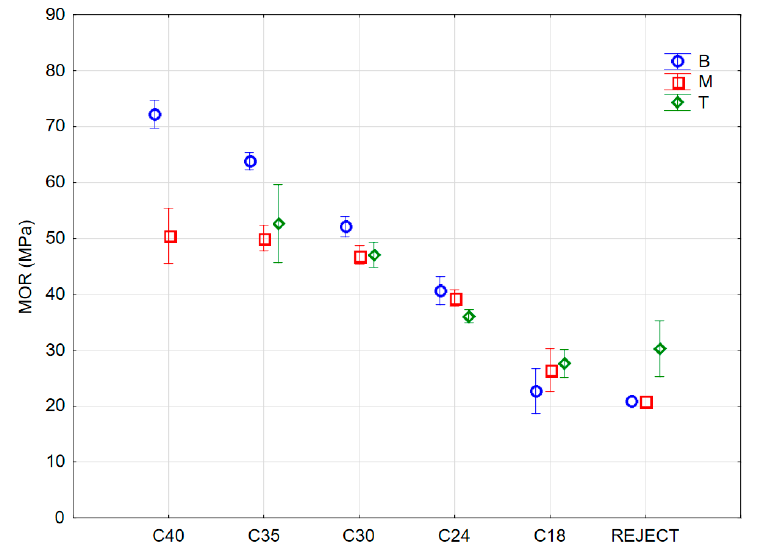
Figure 5. MOR distribution within timber strength classes.